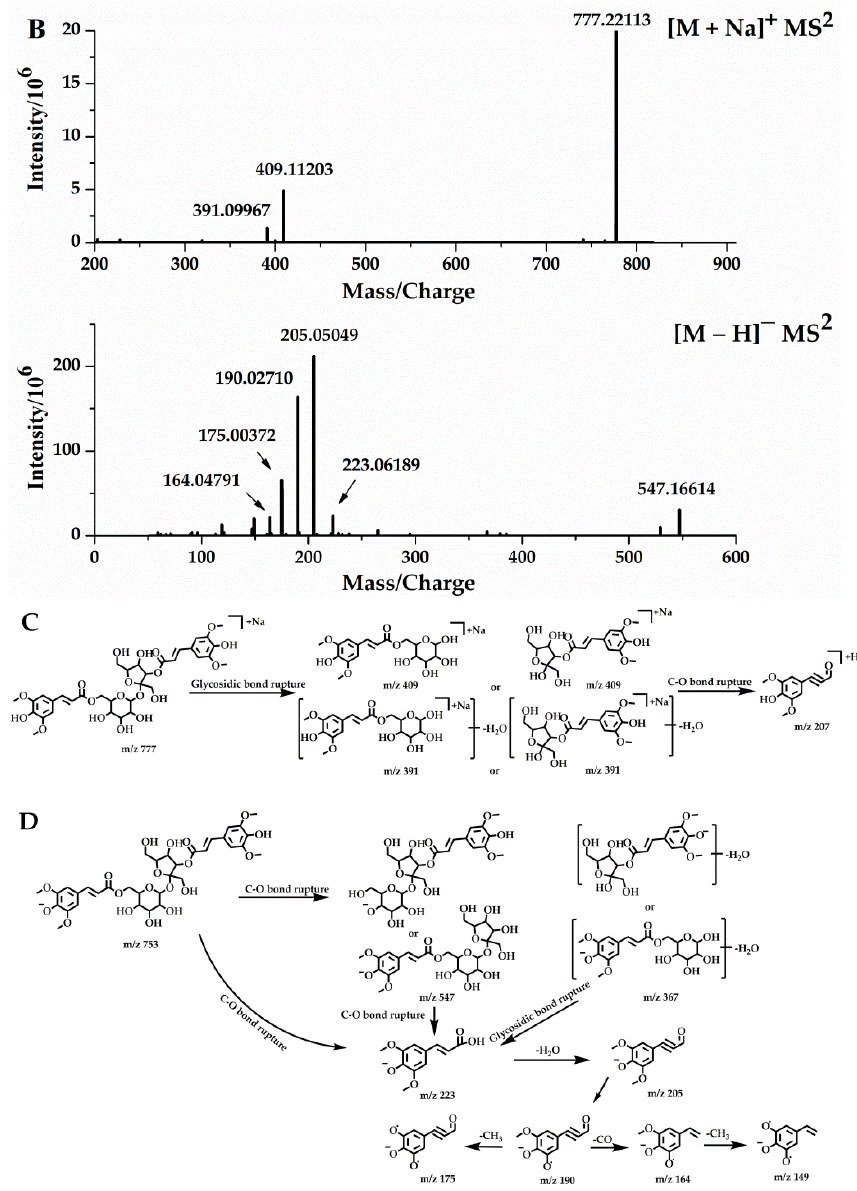
Figure 5. ESI–MS 1 spectra ( A ), ESI–MS 2 spectra ( B ) of DISS in positive and negative modes, the fragmentation behaviors of DISS in positive ion mode ( C ), and negative ion mode ( D ).